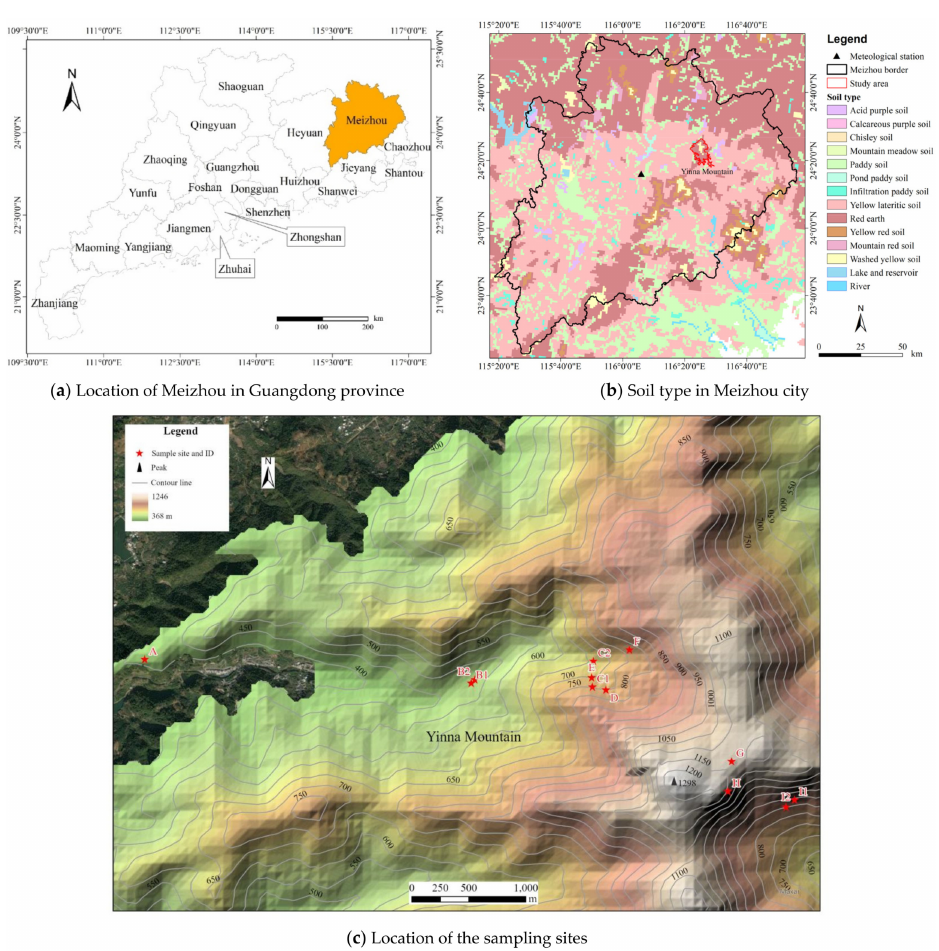
Figure 1. Location and soil map of the study area and sampling